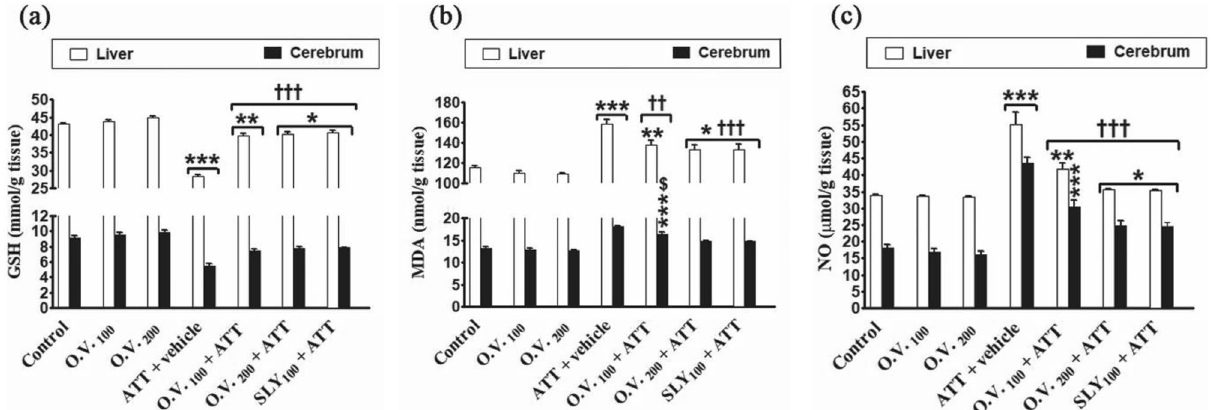
Figure 7. The modulatory effects of O. vulgare on hepatic and cerebrum GSH ( a ), MDA ( b ) and NO ( c ) in the HE-induced rat model. SEM represented by vertical bars. GSH: Reduced glutathione, MDA: Malondialdehyde, NO: Nitric oxide, O.V . : Origanum vulgare , SLY: silymarin. * p < 0.05; ** p < 0.01; *** p < 0.001 (vs. the negative control group).†† p < 0.01; ††† p < 0.001 (vs. the HE positive control group, which received vehicle).